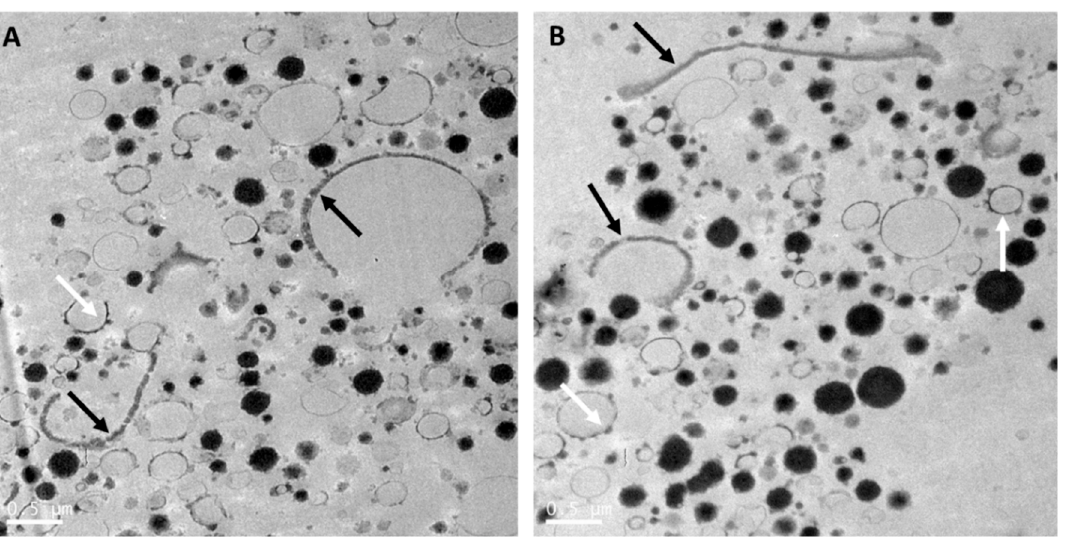
Figure 2. Transmission electron microscopy images ( A and B ) of reconstituted whole goat milk powder (Dairy Goat Co-operative, Hamilton, New Zealand) processed using the same method as in Gallier et al. [5]. Black arrows point at the MFGM surrounding fat globules ( A ) or as fragments in the serum phase ( A and B ). White arrows point at fat globules with adsorbed small casein micelles ( A and B ). Scale bar = 0.5 µm.